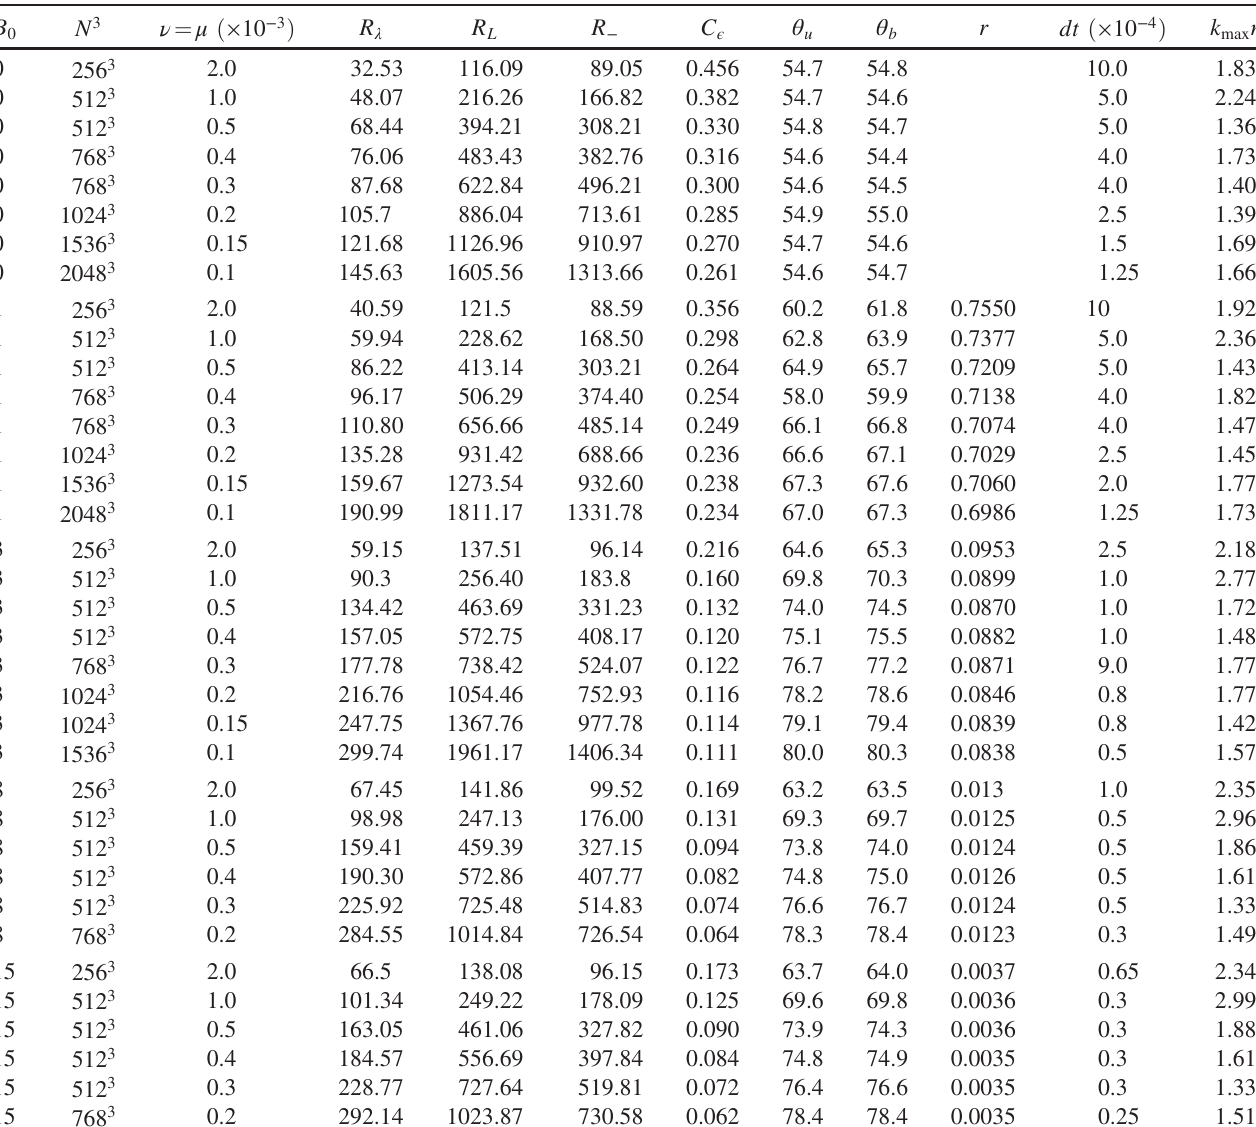
TABLE I. Parameters for three-dimensional spectral simulations: mean magnetic-field strength B 0 , grid resolution N 3 , viscosity and resistivity ν and μ (set equal), Taylor scale Reynolds number R λ , integral scale Reynolds number R L , generalized Reynolds number R − , dimensionless dissipation rate C ϵ , Shebalin angles for velocity field θ u and for magnetic field θ b , square of the ratio of the fluctuation amplitude and mean magnetic field r ¼ ð δ b=B 0 Þ 2 (not applicable for the B 0 ¼ 0 case), time step dt , and ratio of maximum resolved η . See the text for definitions of the quantities. All measurements are made near the time wave number and dissipation wave number k max of maximum